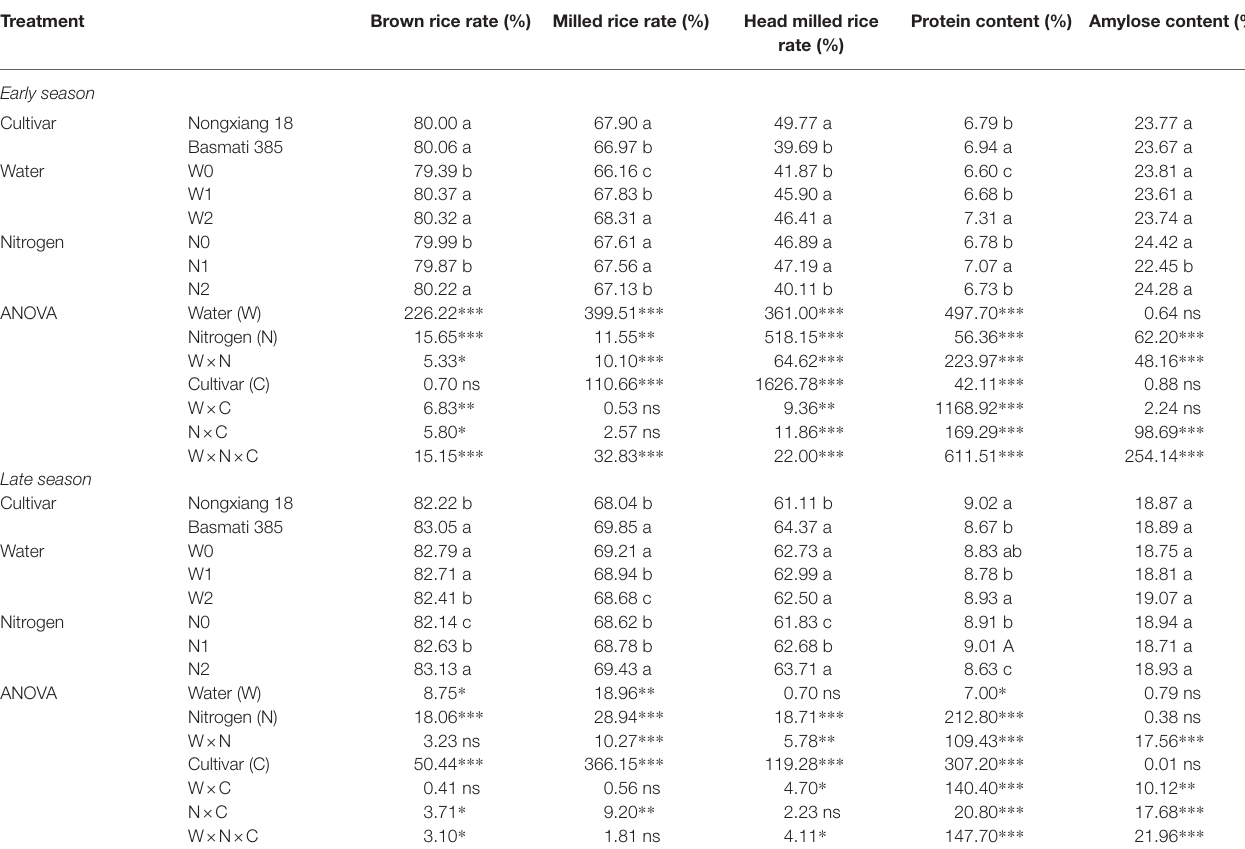
TABLE 5 | Grain quality attributes as affected by water, nitrogen, and cultivar in early and late seasons of double rice cropping system in South China.